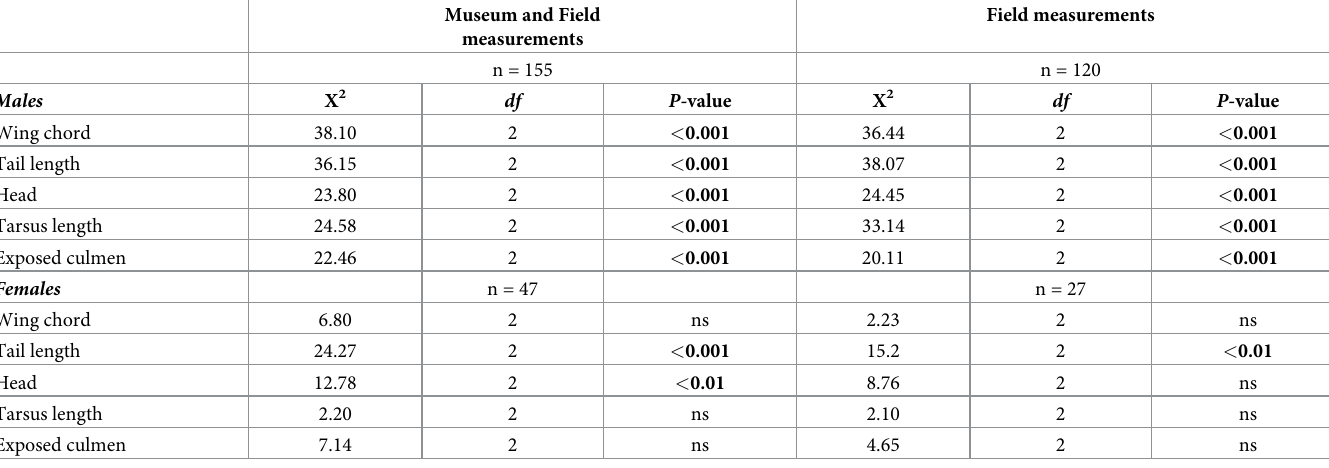
Table 1. Intrasexual comparison of morphological traits among subspecies ( cinereus , sinaloa and russeus ).